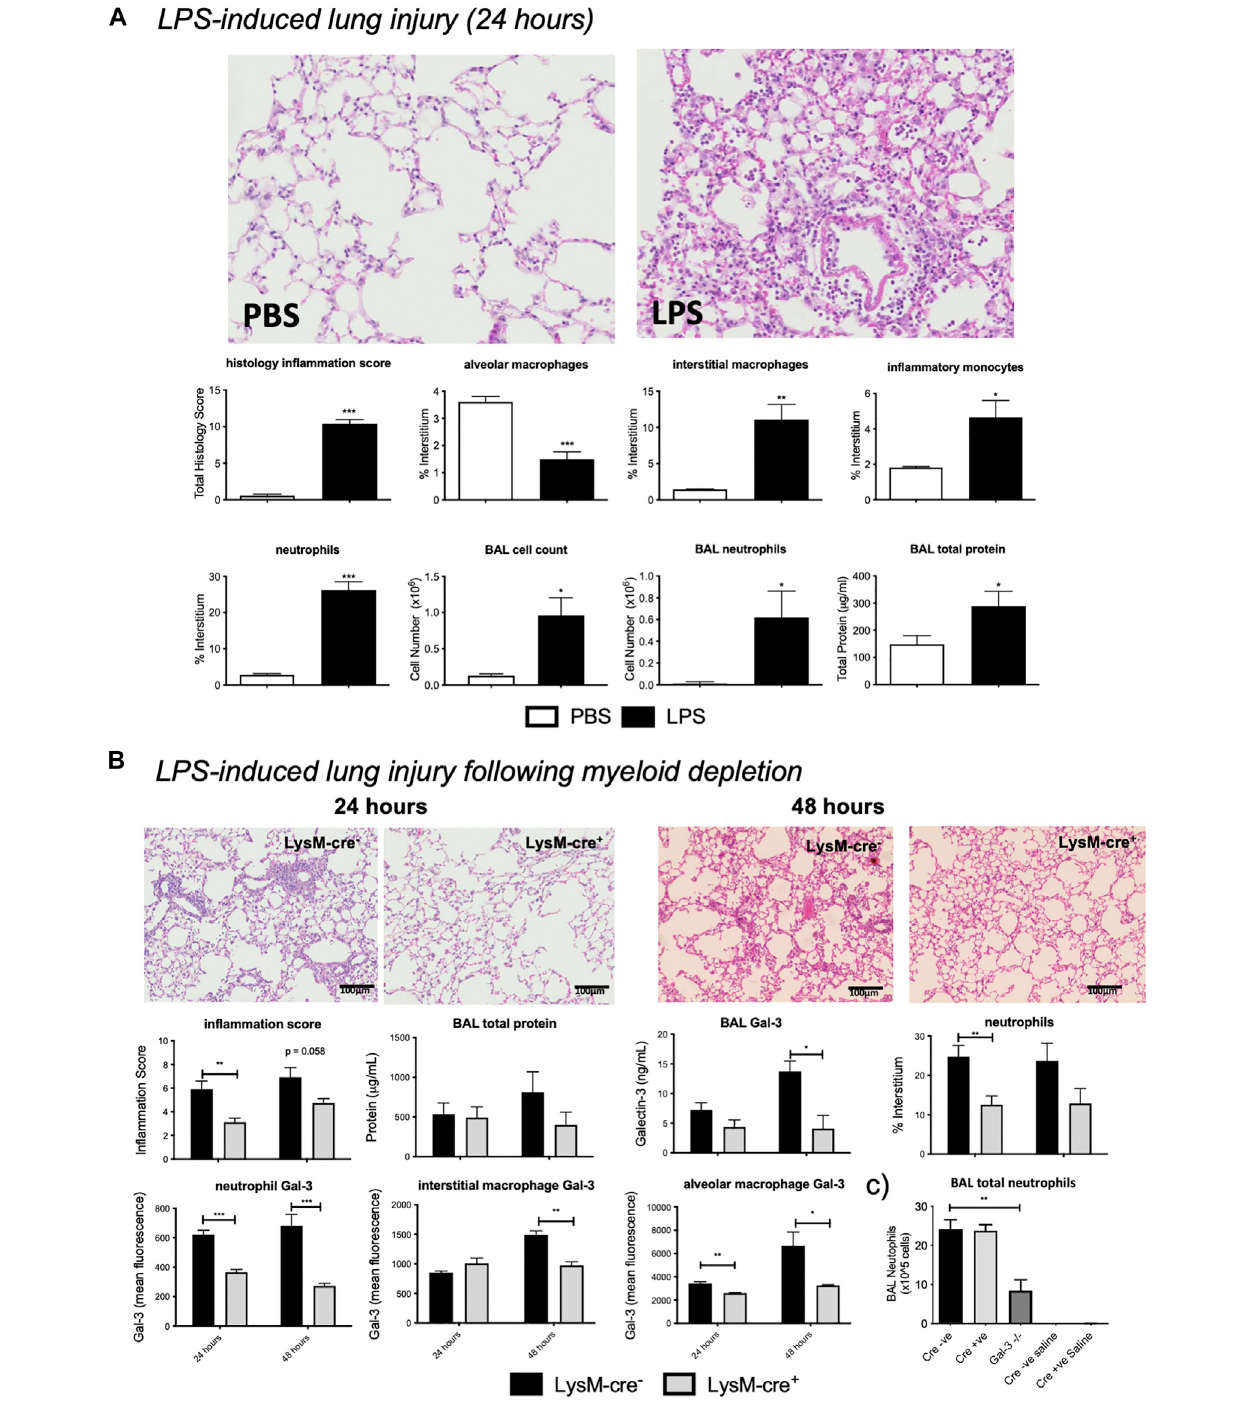
FIGURE 3 | – LPS induced acute lung injury. (A) LPS injury assessment in LysM-cre - mice. LysM-cre - mice received either PBS or 10 µg LPS and were retrieved 24 hlater. (B) EffectofmyeloidcellGal-3depletiononLPS-inducedlungin fl ammation. 10µgLPSwasadministered i.t. to LysM-cre - and LysM-cre + miceandretrievedat 24or48 h.Injurylevelswereanalysedviahistologicalin fl ammationscore,tissuedigestandBALassessment. (C) BALtotalneutrophilsin LysM-cre - , LysM-cre + and Gal- 3 − / − mice following 24 h LPS or saline control. Data represented as mean ± SEM. Analysed via students t-test ( n (cid:1) 4 – 5, ** p < 0.01, *** p < 0.001). Images taken at